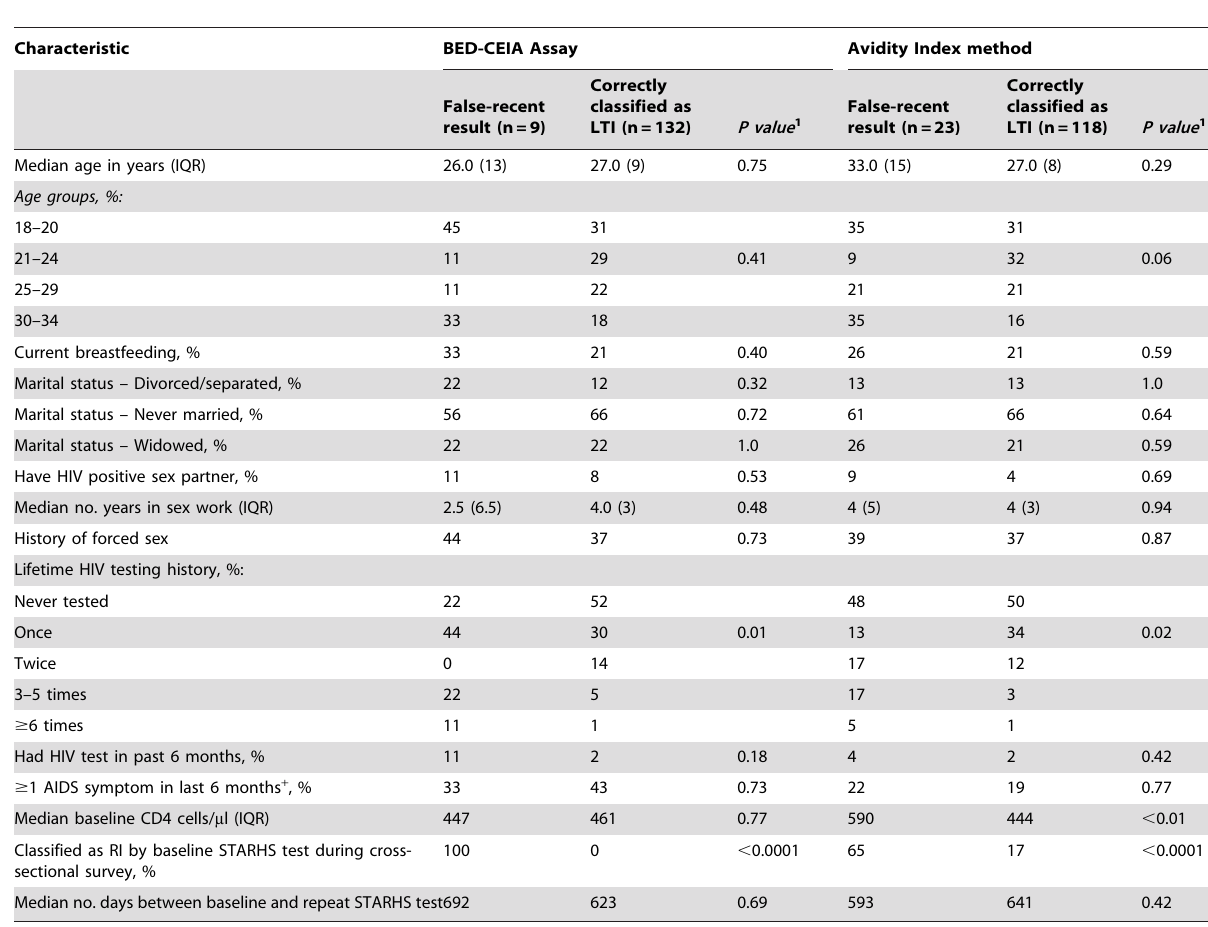
Table 1. Characteristics of cross-sectional survey participants with long-term HIV infection by repeat STARHS test result $ 12 months after HIV diagnosis (N=